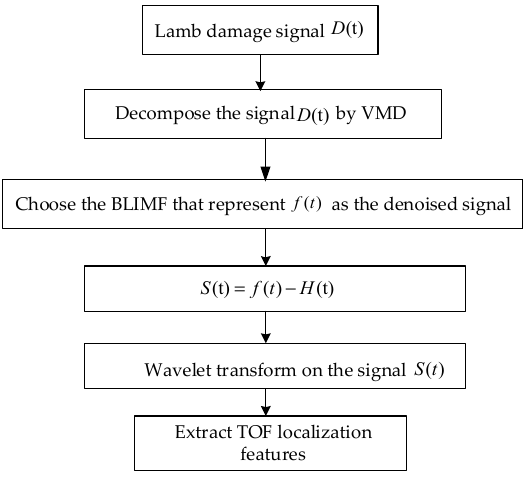
Figure 3. Flowchart of the time of flight (TOF) location feature enhancement and extraction algorithm.